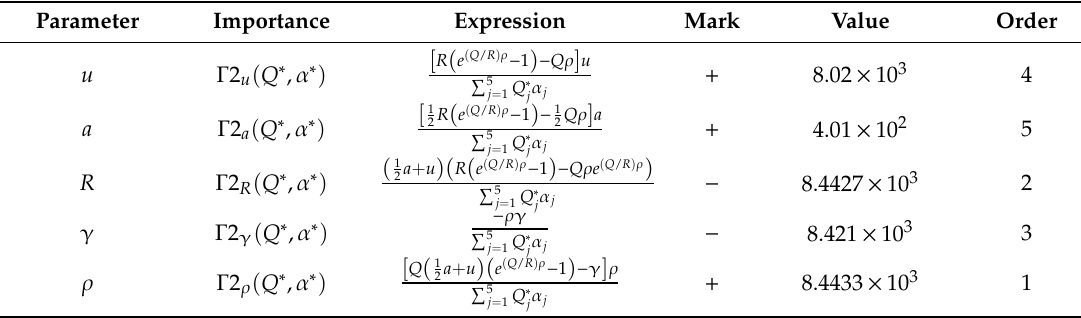
Table 2. Analysis results of di ff erential importance